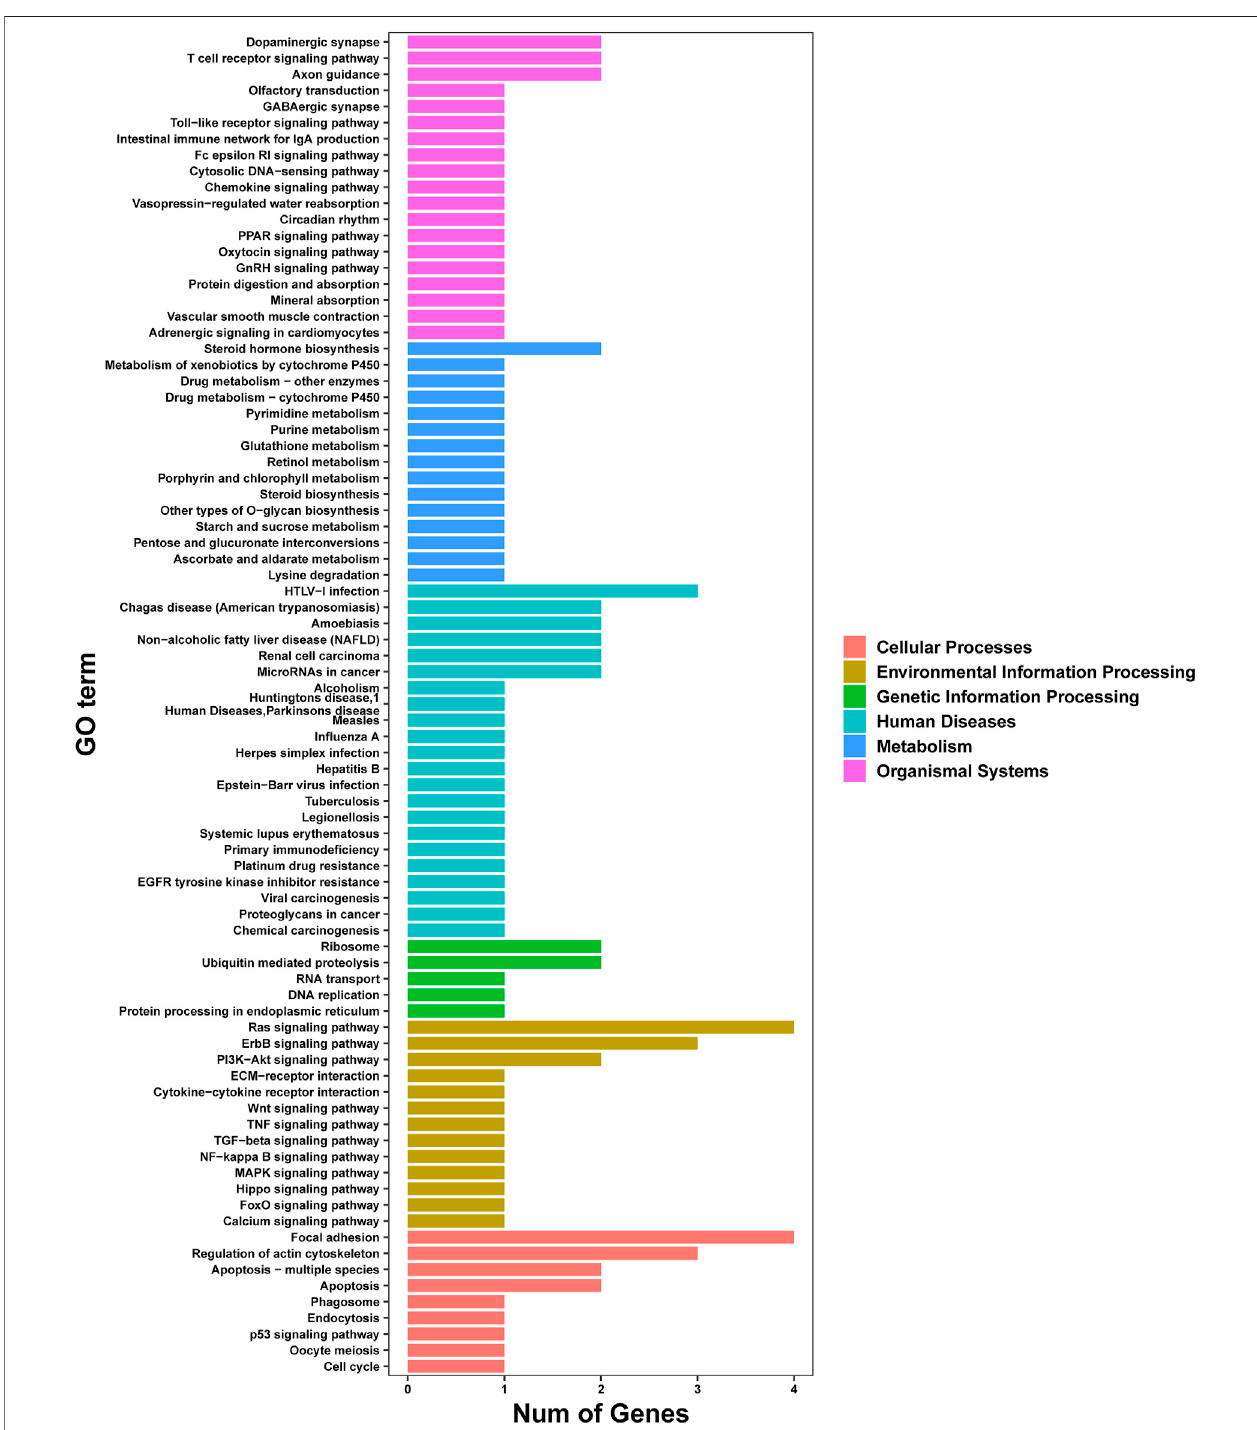
FIGURE 6 | Analysis of pathway enrichment of genes using the KEGG database.